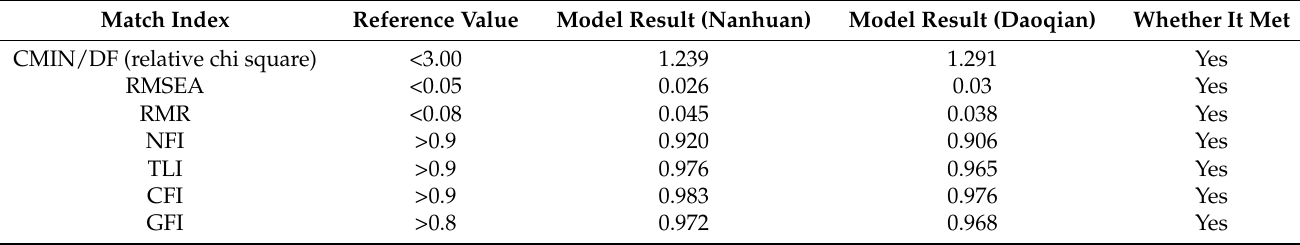
Table 7. Test results for Nanhuan and